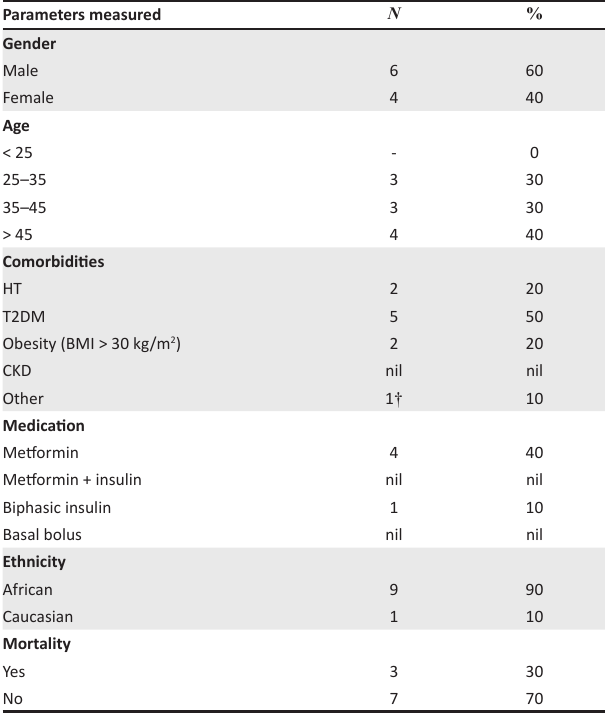
TABLE 1: Demographic parameters and clinical profiles of patients with COVID-19 and diabetic ketoacidosis. Parameters